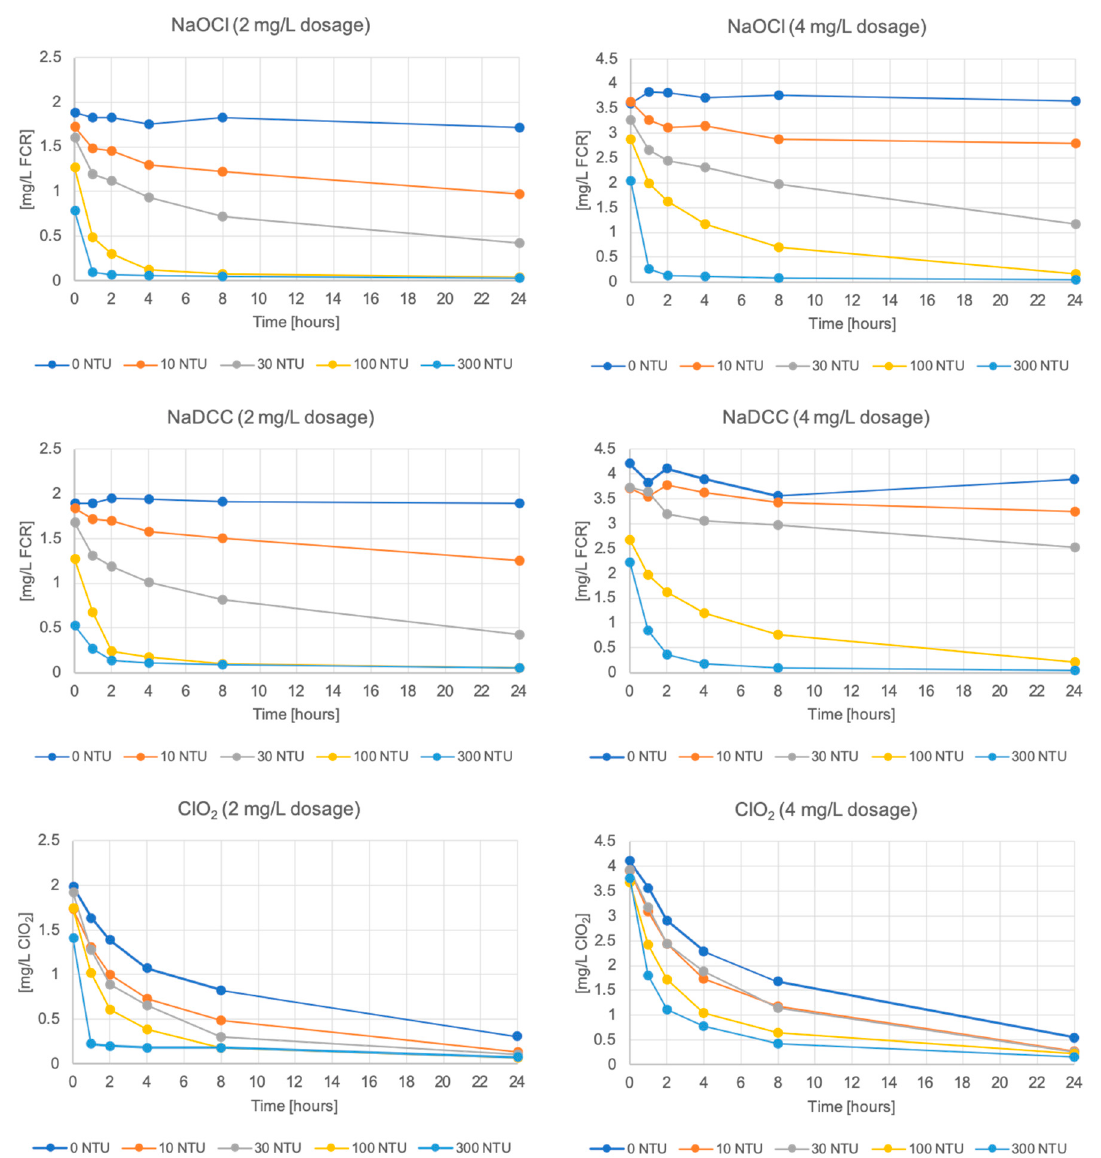
Figure 2. Disinfectant residual concentration over time at constant added TOC (10 mg / L) and varying turbidity from creek-bottom sediments.